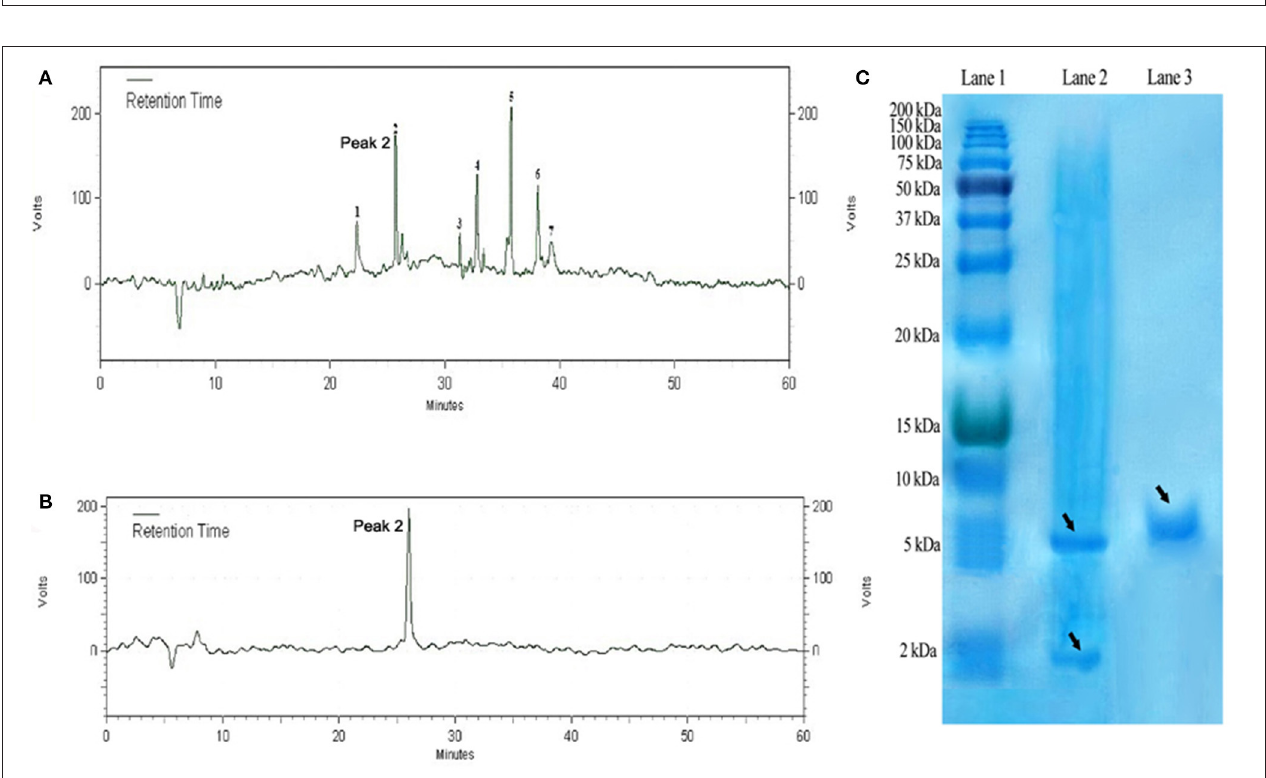
FIGURE 5 | Purification steps of DiMCh-AMP1, which was eluted at 26min. (A) Reversed-phase HPLC purification of DiMCh-AMP1 after cleavage by CNBr. (B) The purity of the labeled peak 2. (C) SDS-PAGE analysis of the HPLC fractions: Lane 1, protein marker; Lane 2, mixture after CNBr cleavage; Lane 3, peak DiMCh-AMP1 collected from HPLC. Proteins were stained with Coomassie brilliant blue. The MW of the purified DiMCh-AMP1 was found to be ∼ 6,172 Da based on the SDS-PAGE analysis. The theoretical MW of DiMCh-AMP1 analysis was calculated as 6,172.04 Da.